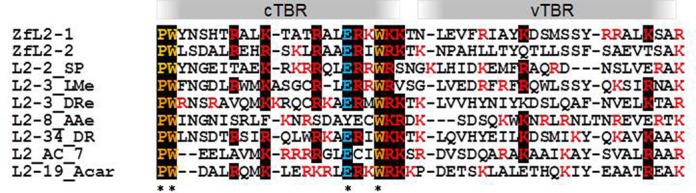
Amino acid sequence alignment of cTBR and vTBR among LINEs of the L2 clade. Residues highlighted in black are conserved among these LINEs. Basic residues are shown in red. ZfL2-1 (accession number 211149) and ZfL2-2 (accession number 211150): zebrafish LINEs used in this study; L2–2_SP: non-LTR retrotransposon from sea urchin; L2–3_LMe: coelacanth non-LTR retrotransposon (consensus sequence); L2–3_DRe: non-LTR retrotransposon from Danio rerio (consensus sequence); L2–8_AAe: non-LTR retrotransposon from Aedes aegypti; L2–34_DR: non-LTR retrotransposon from D. rerio (consensus sequence); L2_AC_7: non-LTR retrotransposon from Anolis carolinensis (consensus sequence); L2–19_Acar; non-LTR retrotransposon from A. carolinensis (consensus sequence). Protein sequences can be accessed from Repbase (56) at http://www.girinst.org/repbase/.